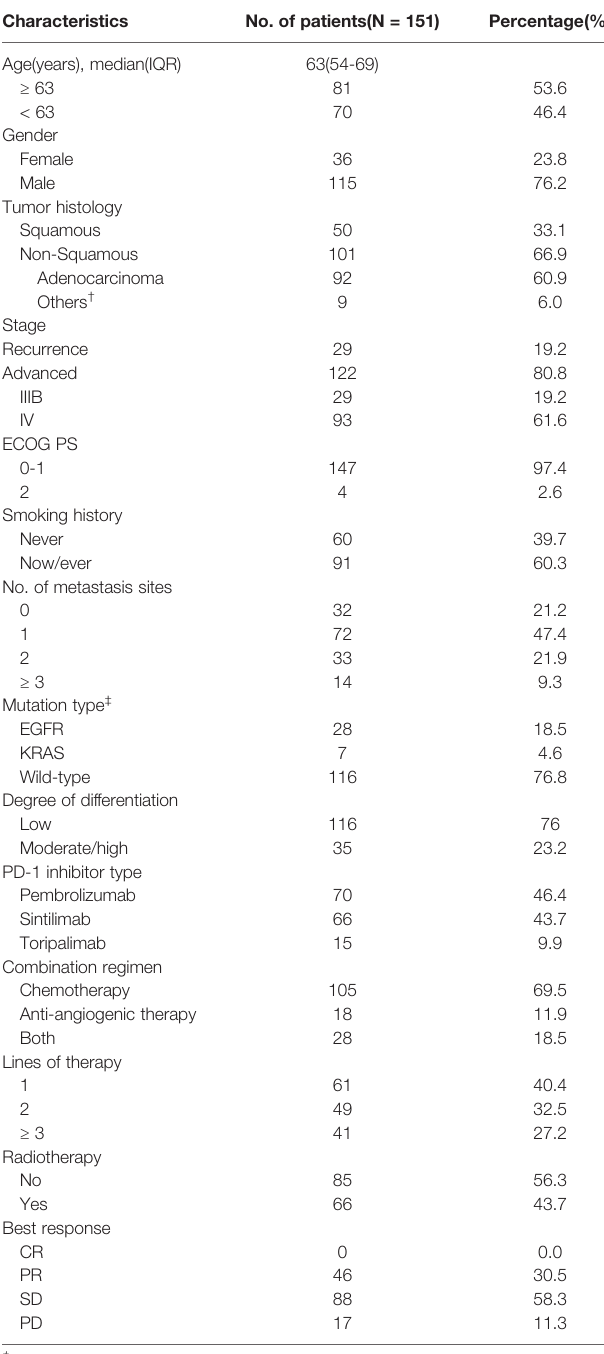
TABLE 1 | Patients ’ characteristics at baseline and treatment